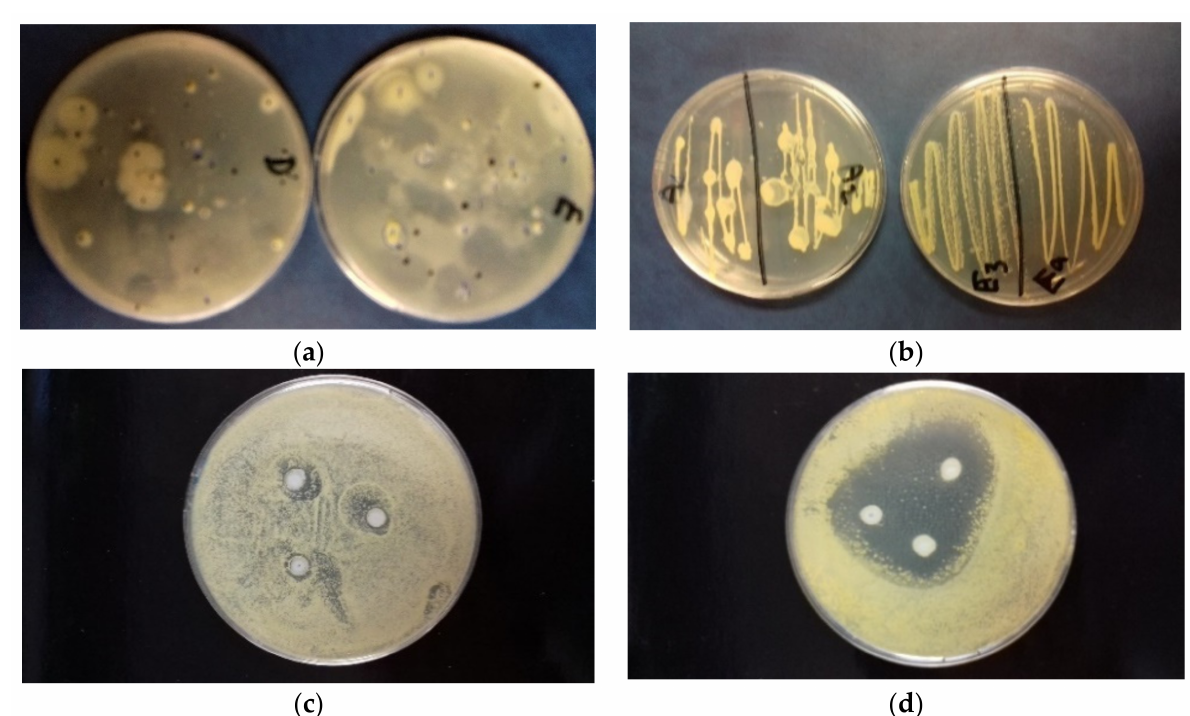
Figure 10. ( a ) Microbial growth on agarized cultural medium from paint surface sampled using the sterile velvet technique. ( b ) Isolation of viable and yellow pigmented bacterial strains, Micrococcus luteus. ( c ) Antibacterial in vitro test carried out with LA 2019 EO and the absence of antimicrobial effects (halo < 6 mm). ( d ) Antibacterial in vitro test carried out with LA 2020 EO and the presence of antimicrobial effects (halo > 6